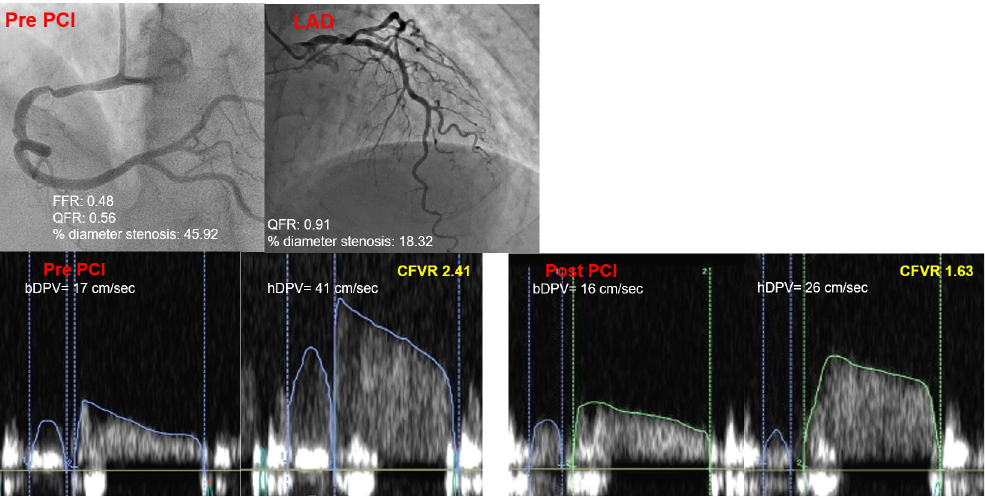
Fig 1. A representative case of a change in LAD-CFVR after non-LAD PCI by transthoracic Doppler echocardiography. An 80-year-old man without a significant stenosis in LAD. After successful RCA-PCI, LAD-CFVR decreased from 2.41 to 1.63 due to the reduction of hDPV. LAD, left anterior descending artery; CFVR, coronary flow velocity reserve; PCI, percutaneous coronary intervention; RCA, right coronary artery; hDPV, hyperemic peak diastolic